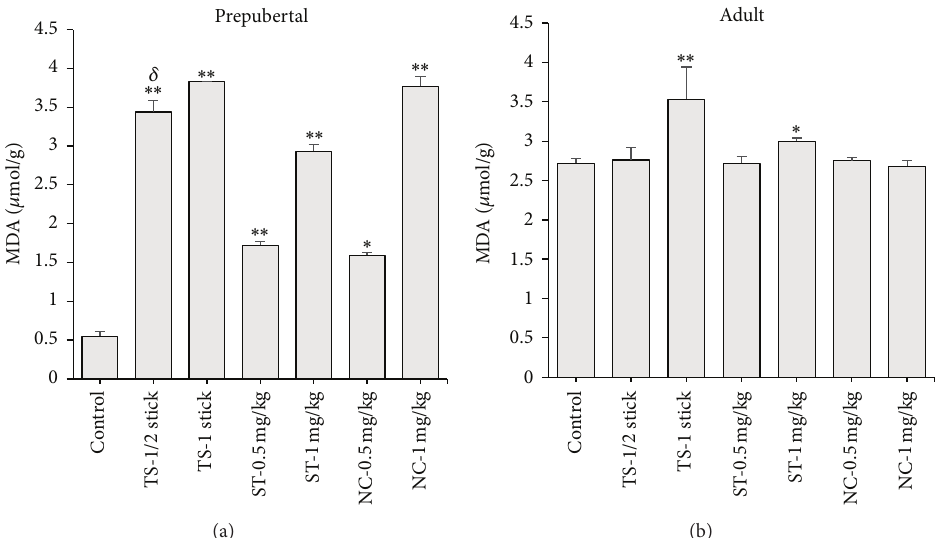
Figure 3: Levels of malondialdehyde (MDA) in testis of prepubertal (a) and adult rats (b) following daily exposure to cigarette smoke (tobacco smoke, TS), smokeless tobacco (ST), and nicotine for 30 days. Data are expressed as mean ± SEM ( 𝑛 = 6 ). ∗ 𝑝 < 0.05 compared to control; ∗∗ 𝑝 < 0.01 compared to control; 𝛿 𝑝 < 0.05 compared to ST-0.5 mg/kg and NC-0.5 mg/kg.